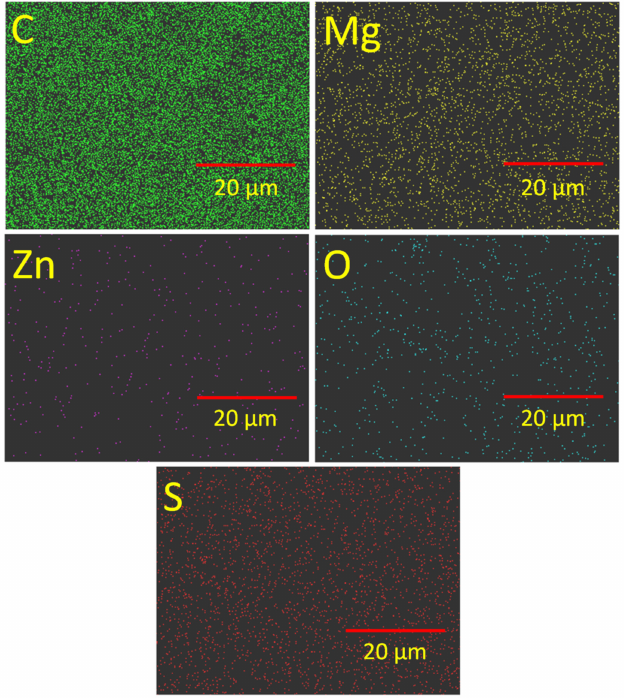
Figure 8. Particle distribution through EDS-mapping in NR/3-MgO/2-ZnO compound.